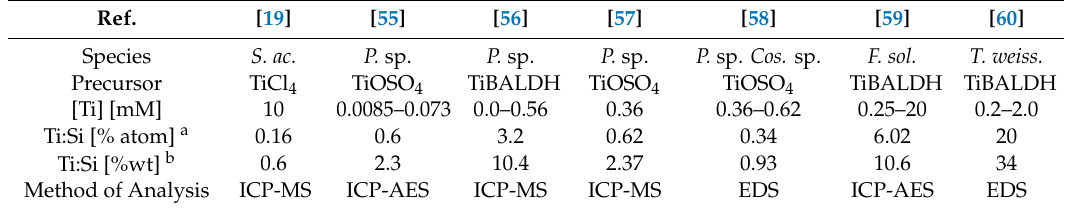
Table 2. Summary of applied conditions for the cultivation of diatoms and the degree of incorporation of titanium into diatomaceous